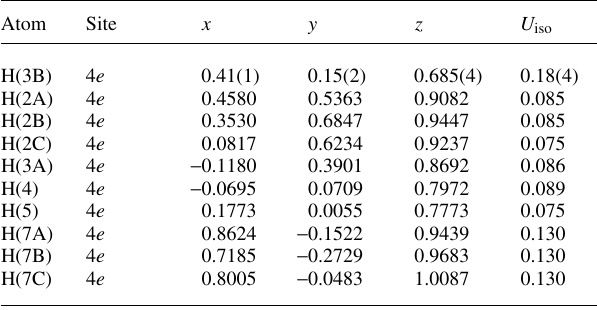
Table 2. Atomic coordinates and displacement parameters (in Å 2 )